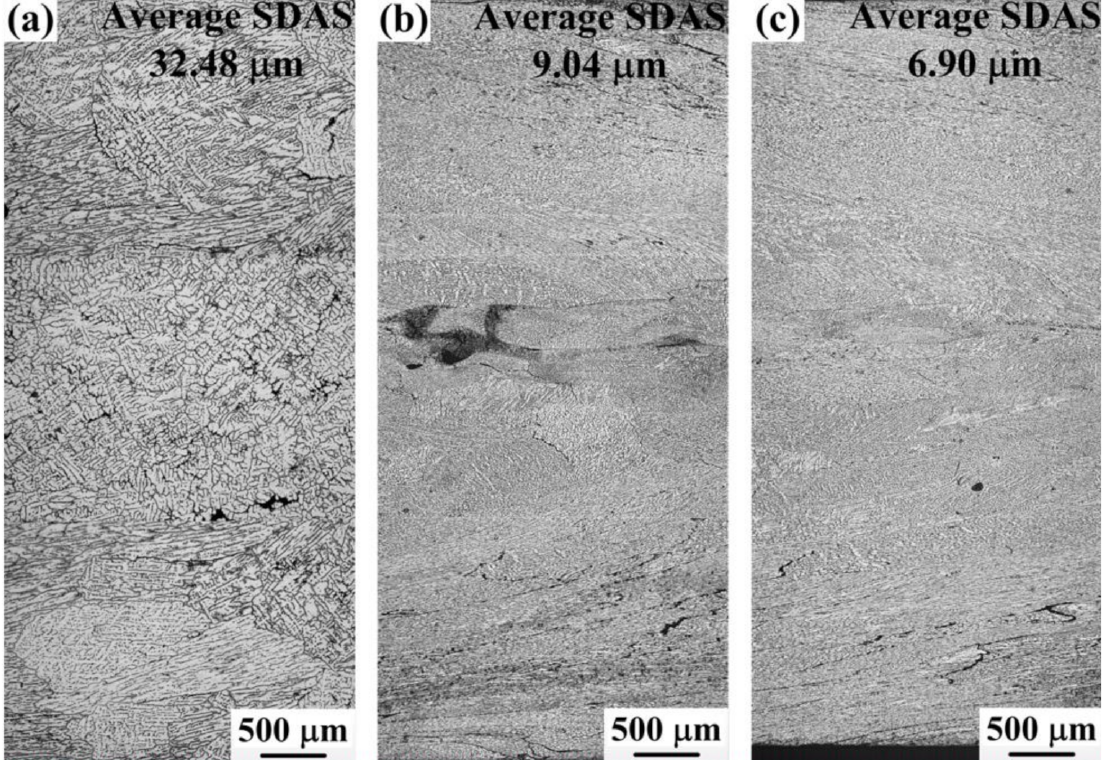
Figure 2. The micrographs and SDAS of the longitudinal section of Al-Cu-Li alloys: ( a ) ingot alloy; ( b ) TRC plate; ( c ) electromagnetic oscillation field TRC